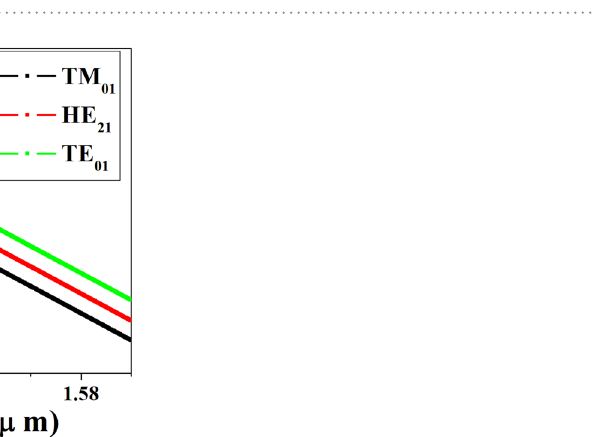
Figure 4. Measured Brillouin gain spectra for fundamental and high-order vector modes, and corresponding Gaussian fit curves.